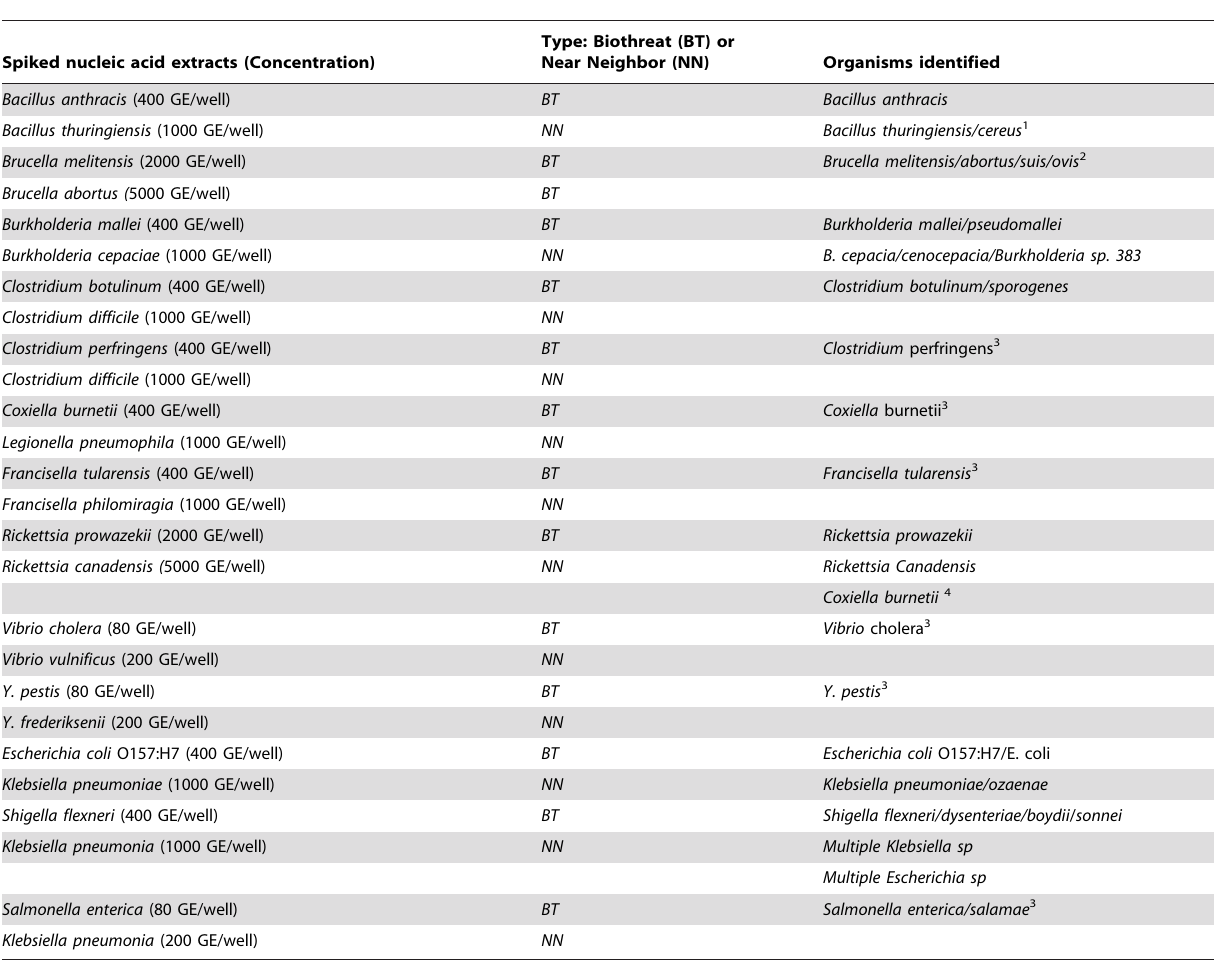
Table 5. Specificity of the biothreat assay as measure by near-neighbor challenge.